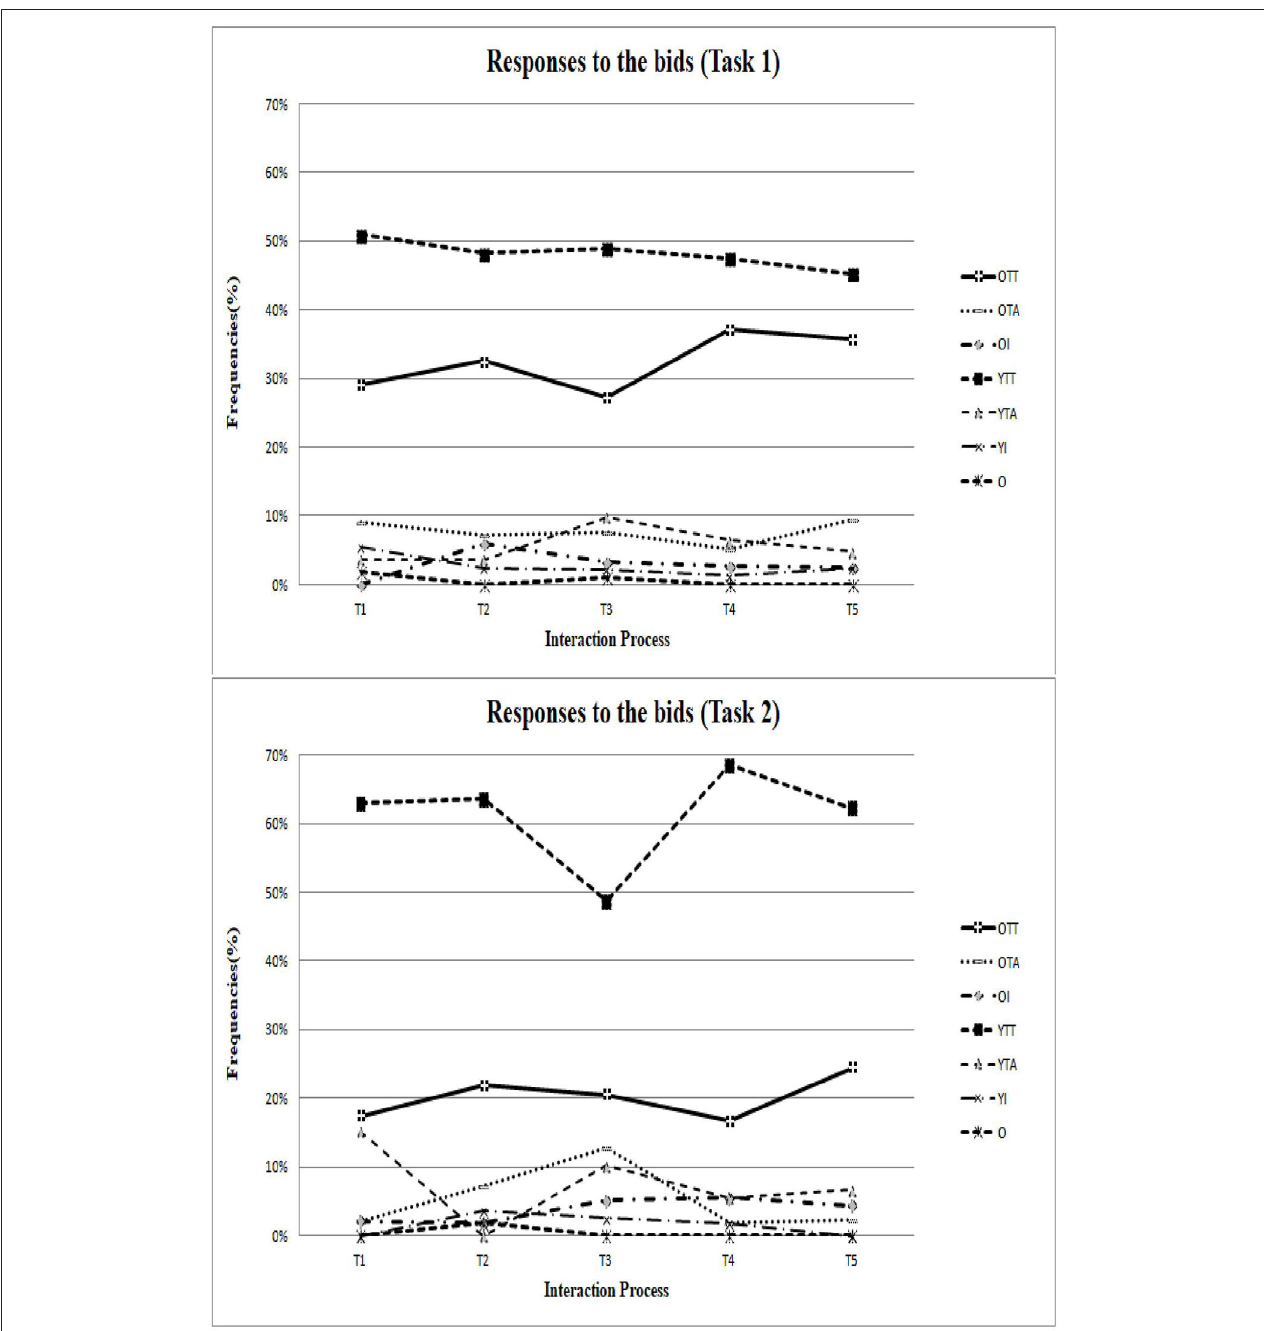
FIGURE 3 | The patterns of response to the bids in Task 1 and Task 2.